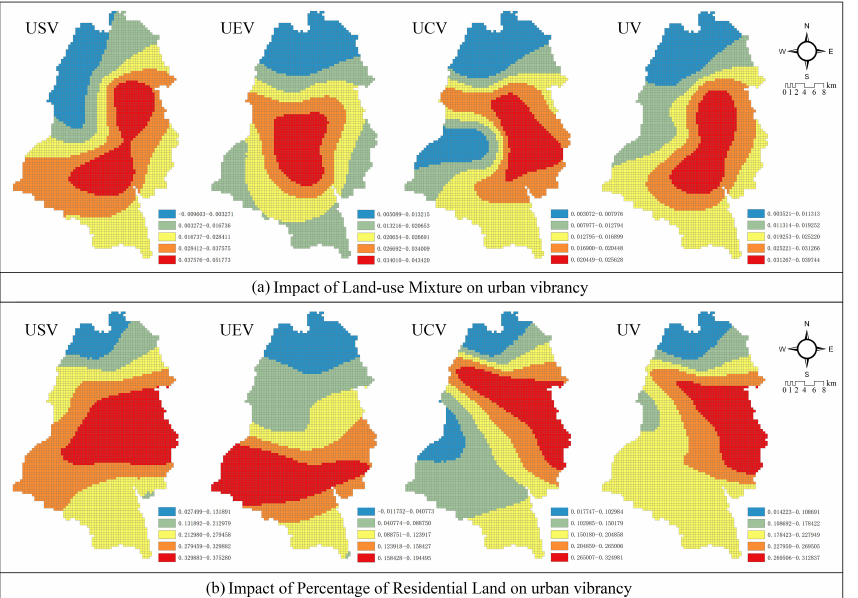
Figure 5. Impact of diversity of land-use on various urban vibrancies. ( a ) Impact of Land-use Mixture on Urban Vibrancy. ( b ) Impact of Percentage of Residential Land on Urban